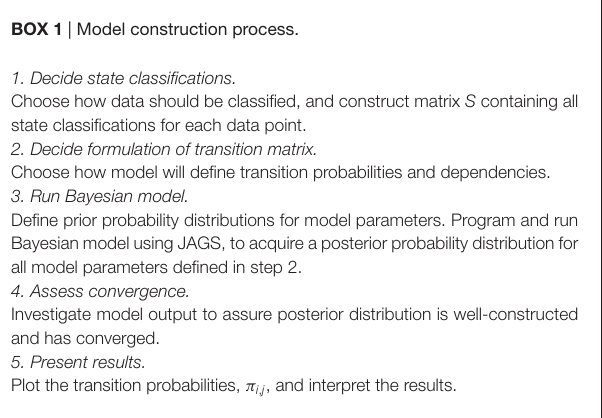
BOX 1 | Model construction